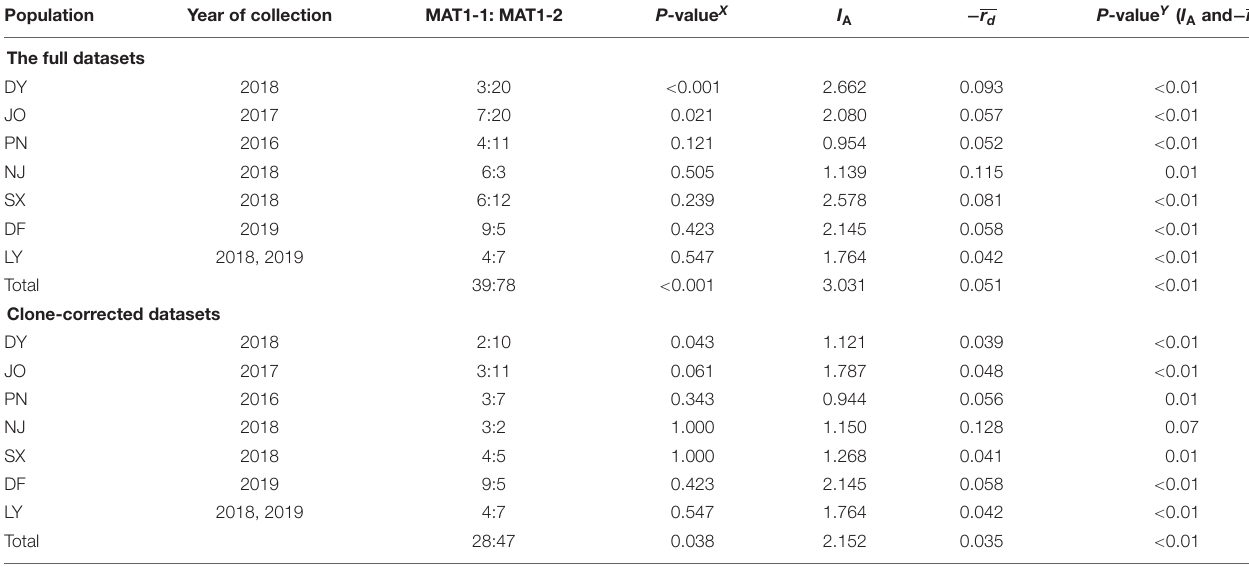
TABLE 6 | Multi-locus linkage disequilibrium analysis of Setosphaeria turcica populations collected from seven regions in Fujian Province using full and clone-corrected datasets. Population Year of